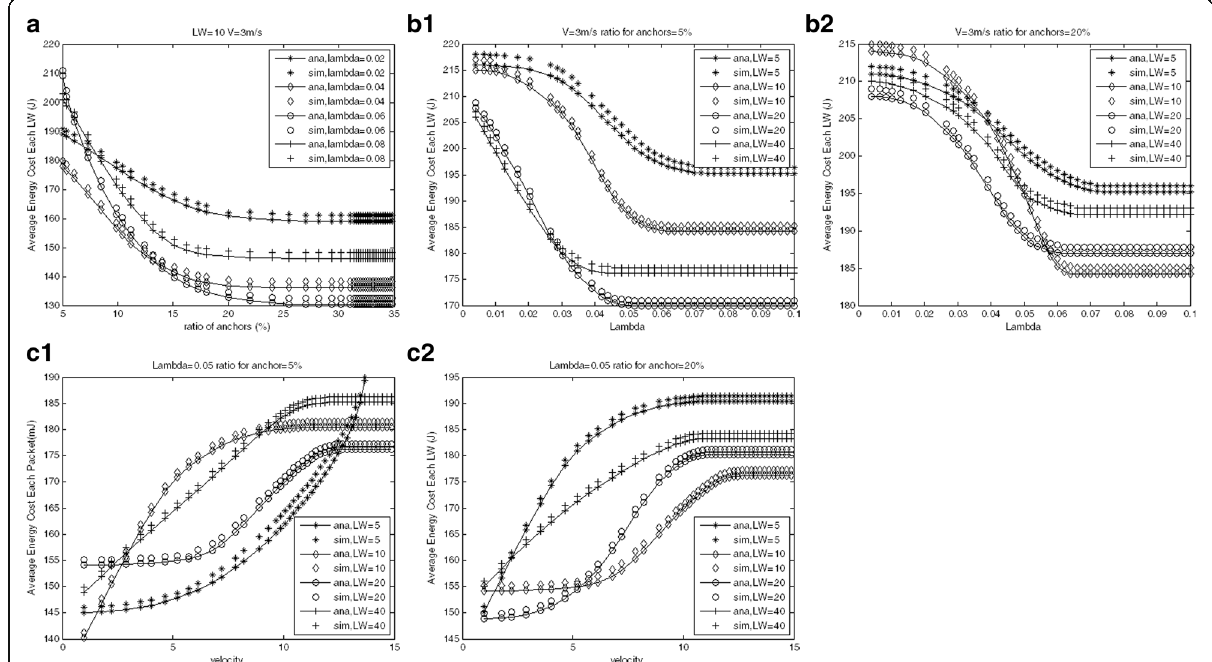
Fig. 9 a Localization energy for node density as a function of anchor ratio. b Localization energy for localization window as a function of node density. c Localization energy for localization window as a function of mobility